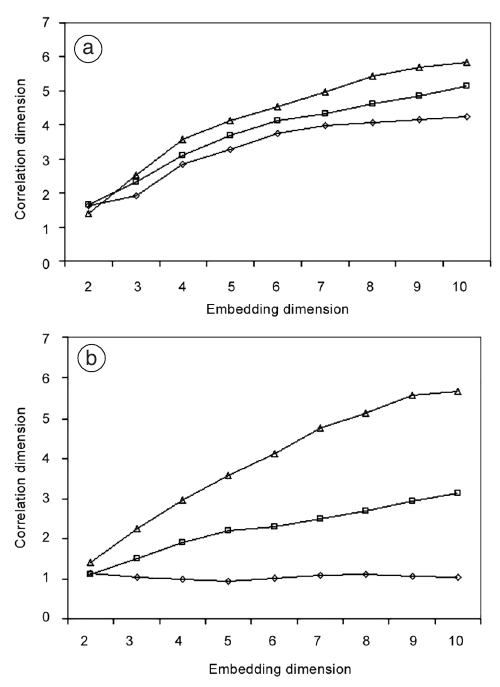
Fig. 6a,b. Correlation dimension versus embedding dimension of original (diamonds) and surrogate (squares – GSRP, triangles – RP) waiting time se- quences: a) before beginning of experiments, b) dur- ing